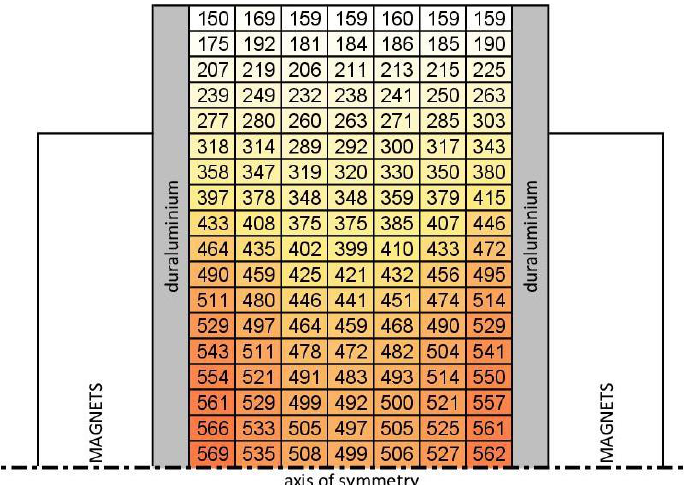
Figure 18. The results of induction distribution measurement in the machining gap [×10 −3 T]. The